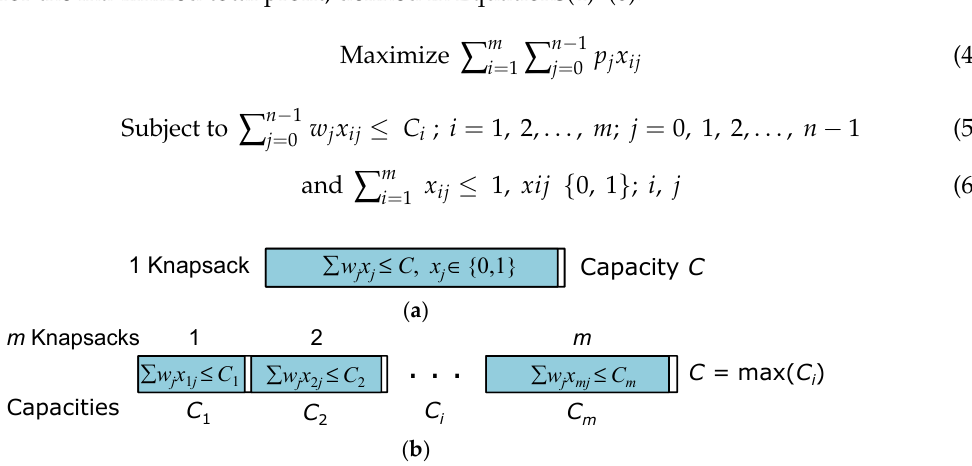
Figure 1. Two different 0/1-knapsack problems ( n objects): ( a ) the popular 0/1-KP (one knapsack with capacity C ) and ( b ) the complex 0/1-mKP ( m knapsacks with capacity C i , i = 1, 2, …, m ).